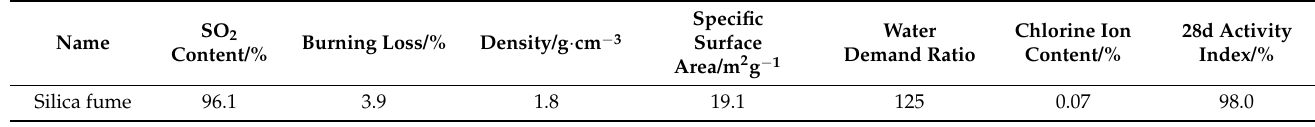
Table 2. Physical properties of silica fume.